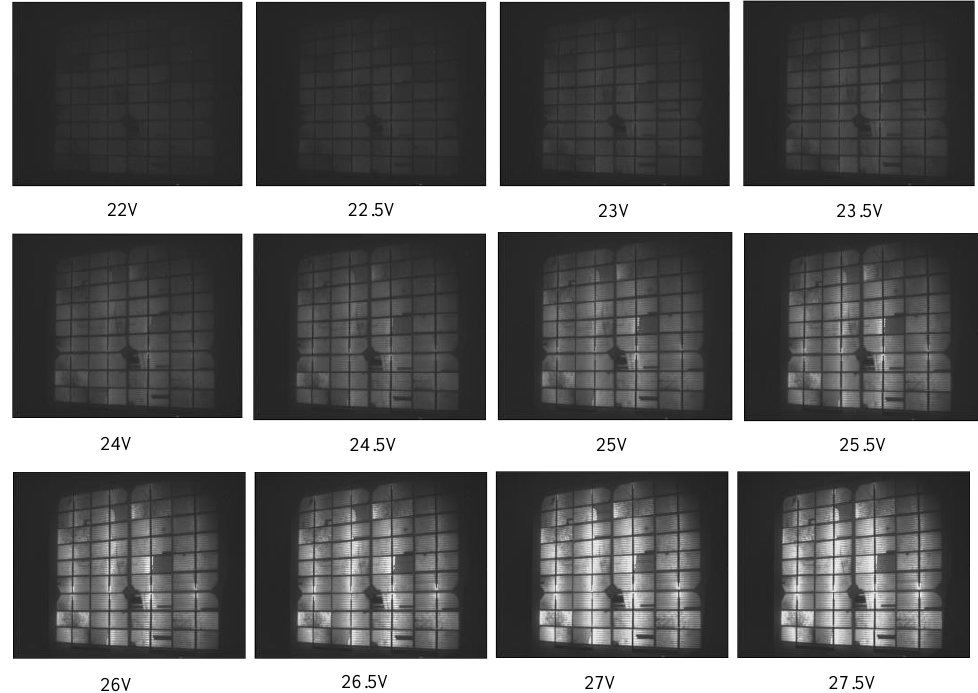
Figure 13. Images I of monocrystalline silicon photovoltaic panel with bias voltages.